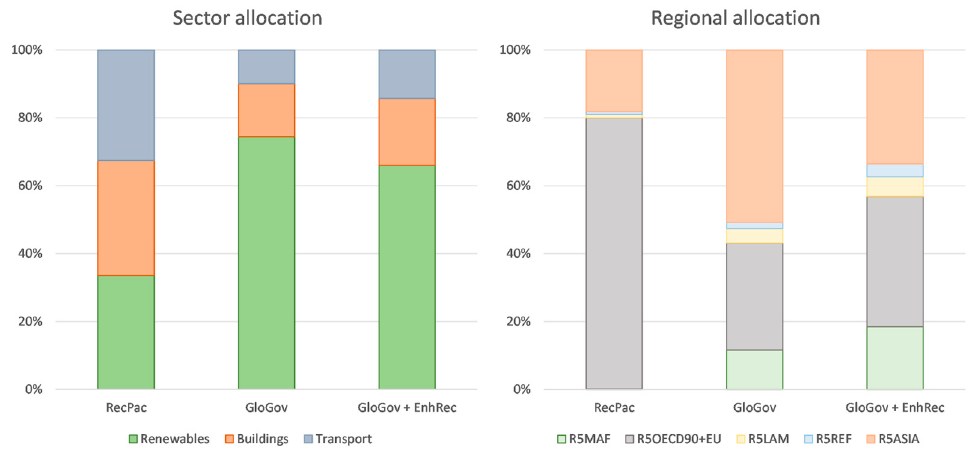
Figure 5. Investment allocation by regions and sectors in Global Governance scenario. Note: R5MAF (Middle East and Africa), R5OECD90 + EU (OECD countries), R5LAM (Latin America), R5REF (Rest of the World), R5ASIA (Asia).